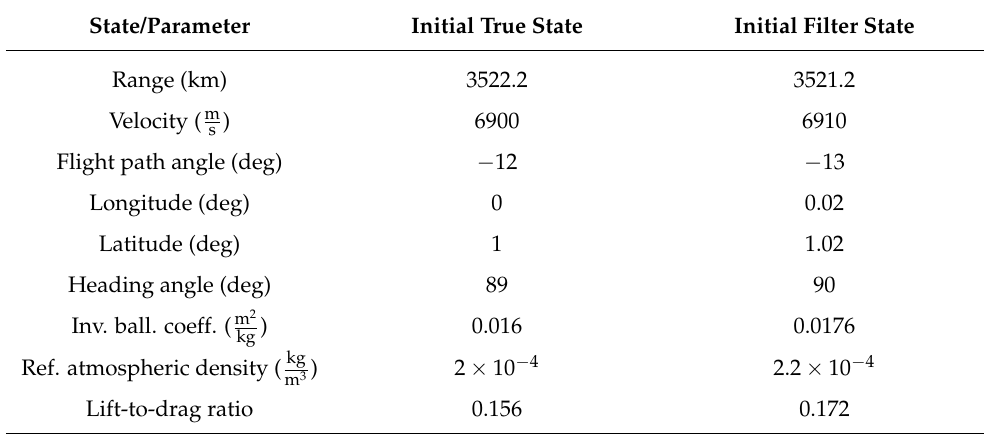
Heading angle (deg)